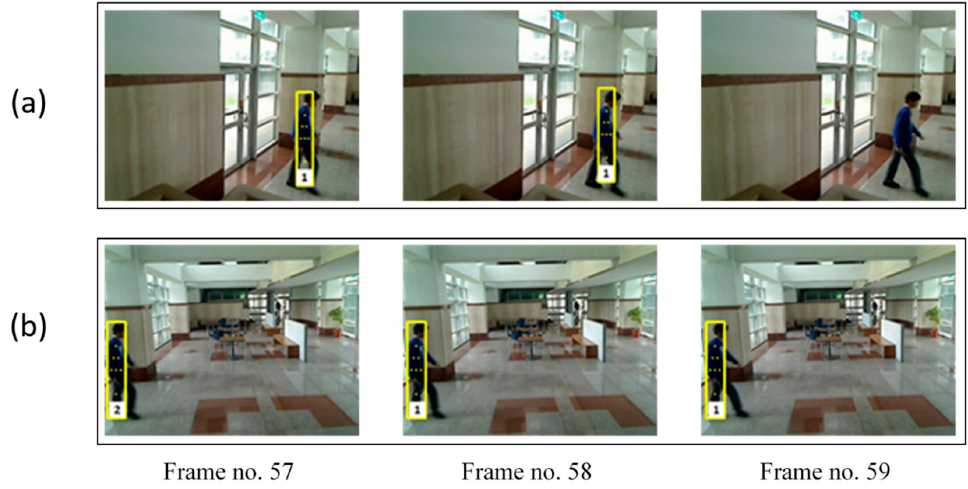
Figure 14. Tracking token transfer between Cam1 and Cam2 in single person tracking scene. Figure 15. Tracking token transfer between Cam1 and Cam2 in single person tracking